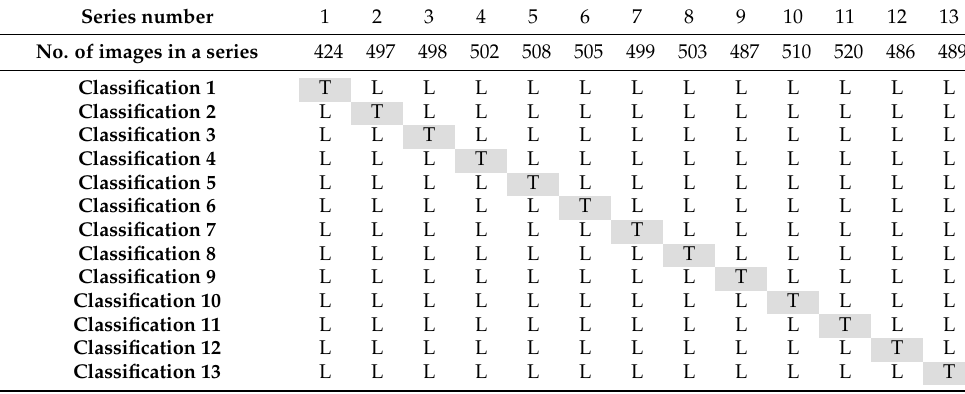
Table 11. Learning and test sets for 13 classifications 1